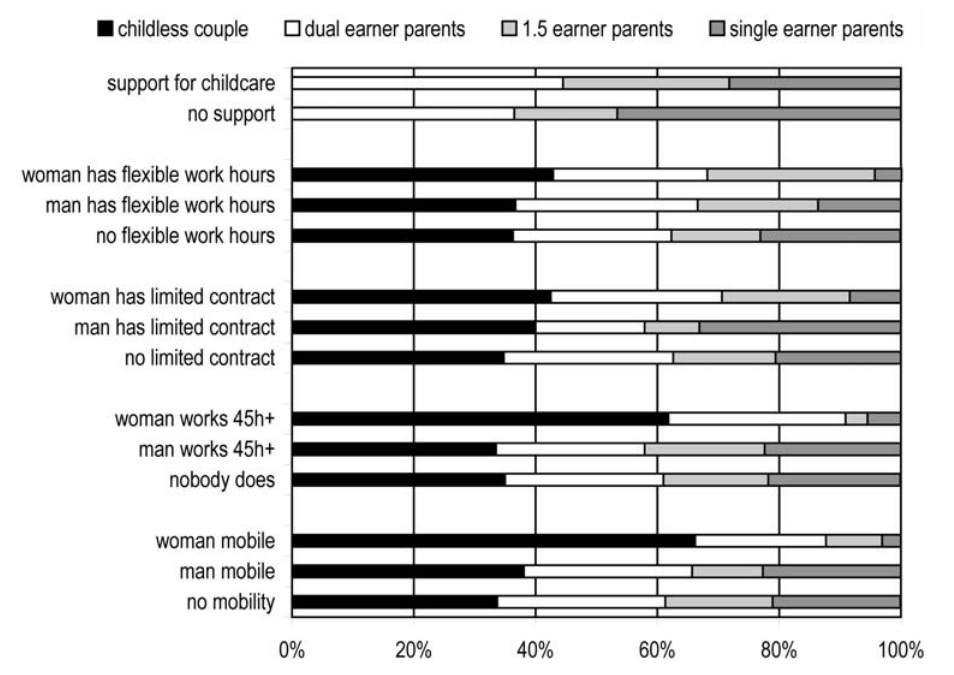
Figure 2 : Couples’ childlessness and number of jobs by other circumstances